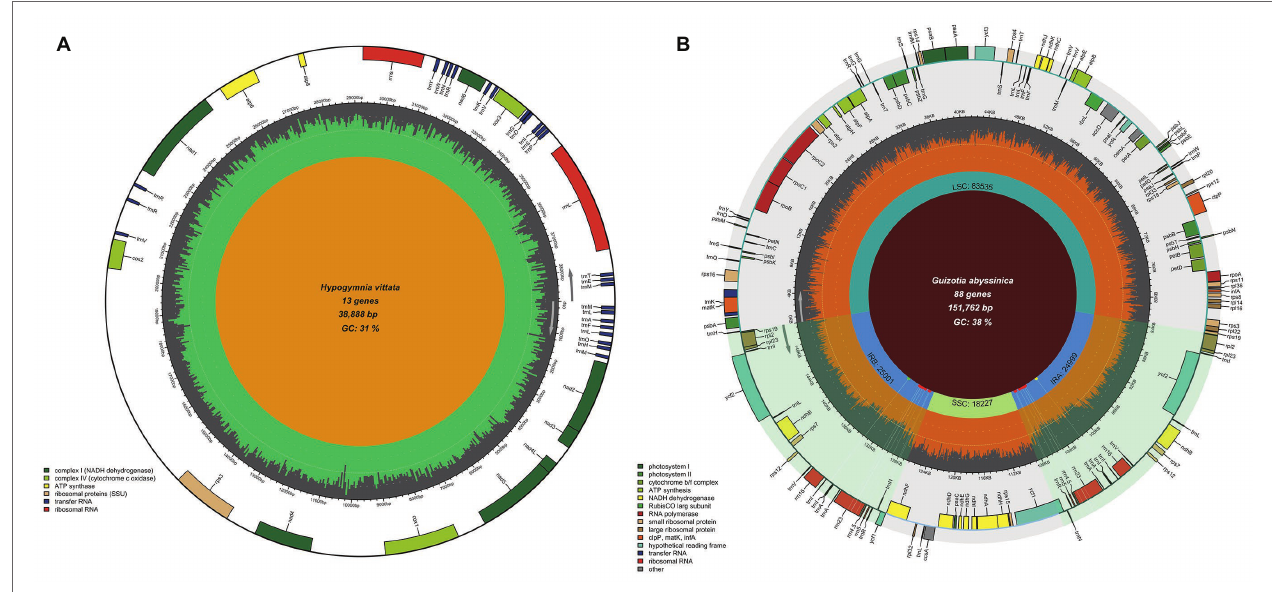
FIGURE 3 | Mitochondrial genome map and chloroplast IR mismatching capabilities. Chloroplot can automatically distinguish organelle genome types and plot the respective elements of each genome, as well as detect the differences between IR regions in the plastid genome. (A) The mitochondrial genome map of Hypogymnia vittata (Ach.) Parrique (1898) with configurable functional gene families. (B) The detection of SNPs, insertion, and deletion of the nucleotides causing differences in the two IR regions of Guizotia abyssinica . The bold dots on the inner circle of the IR regions, each with a corresponding shadow extending outward with green, red, and yellow colors indicate the existence of the insertion, SNPs, and deletion on the corresponding genomic coordinates,